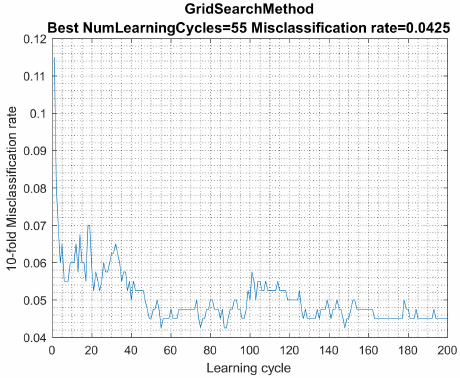
Figure 15. The results of the grid search method of AdaBoost.